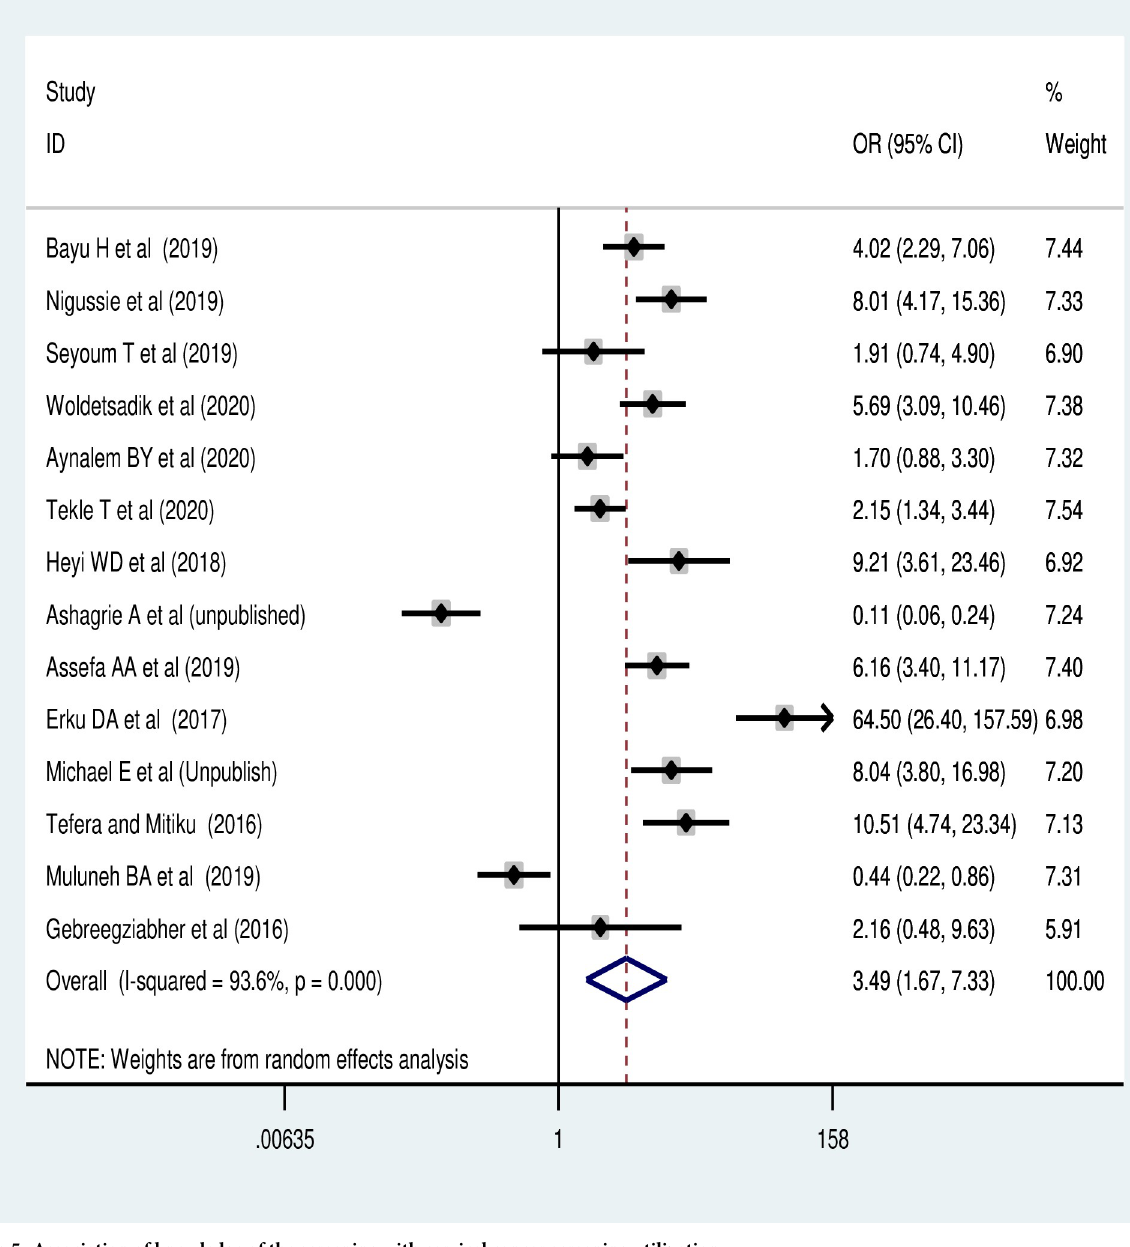
Fig 5. Association of knowledge of the screening with cervical cancer screening